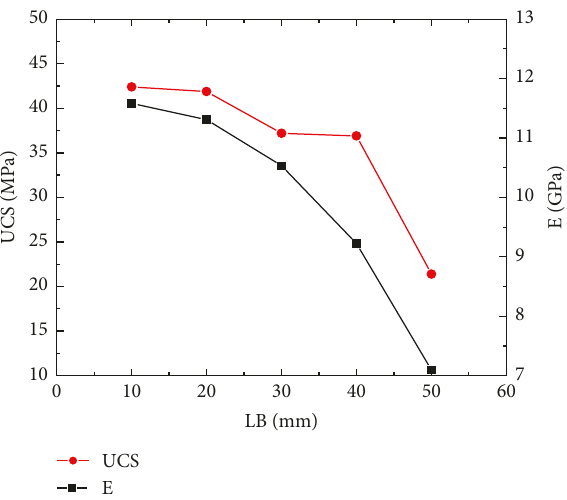
Figure 7: UCS and E of rocks with different joint